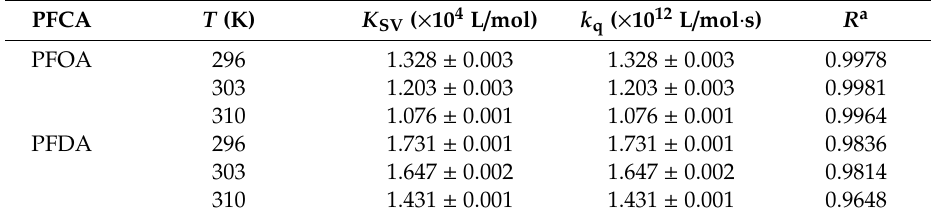
Table 1. Stern–Volmer quenching constants of the PFCA–HSA system at di ff erent temperatures.